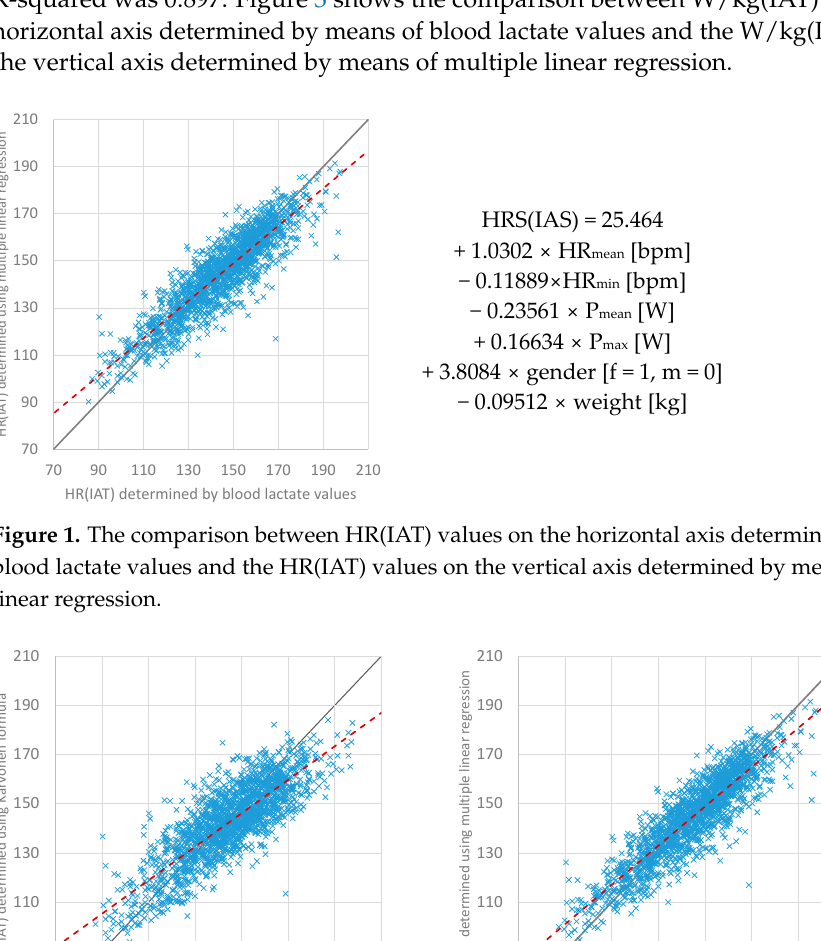
(HR max ). Using these parameters in multiple linear regression (Figure 3), the determination of W/kg(IAT) is possible with a root mean square error, RMSE = 0.241 W/kg. The adjusted R-squared was 0.897. Figure 3 shows the comparison between W/kg(IAT) values on the horizontal axis determined by means of blood lactate values and the W/kg(IAT) values on the vertical axis determined by means of multiple linear regression.